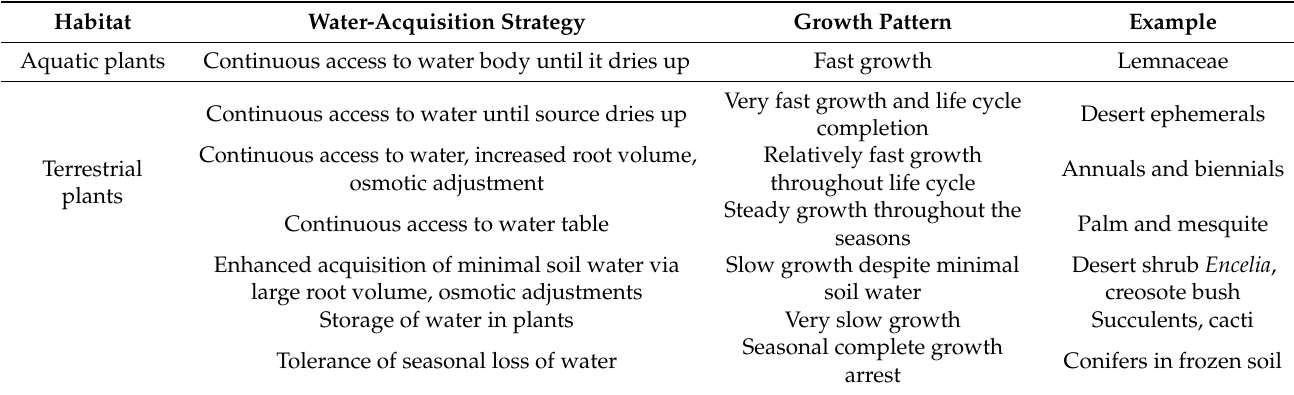
Table 1. Water-acquisition strategies, growth patterns, and species examples that illustrate the continuum of plant adaptations to water